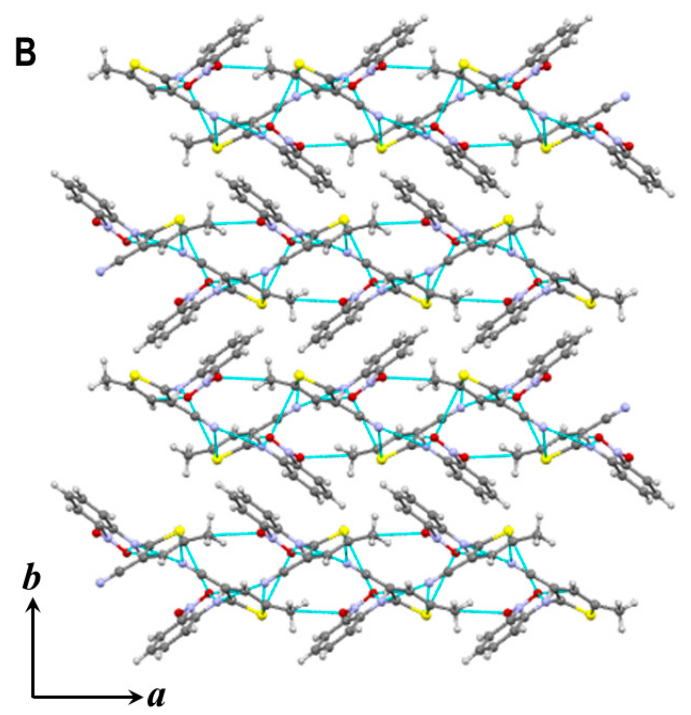
Figure 4. Crystal packing in polymorph Y showing ( A ) very dense hydrogen-bonded network along axes a and c , and ( B ) molecules arranged in alternating dimers with less dense packing along axis b . Weak hydrogen bonds are shown as teal lines.